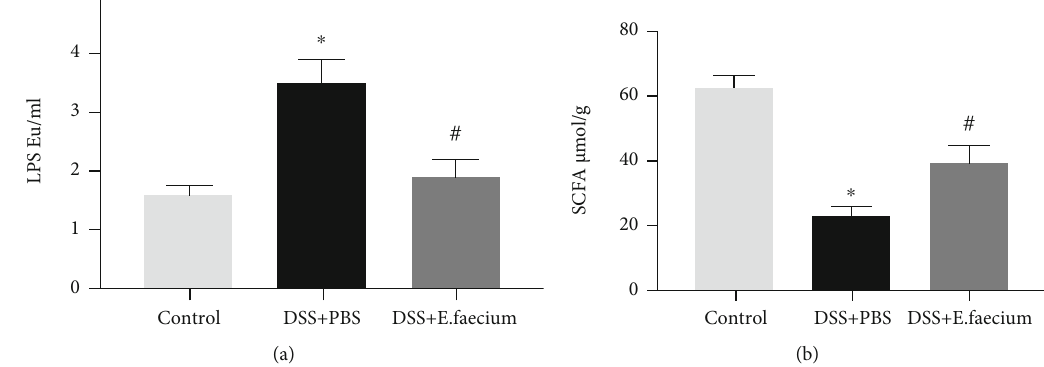
Figure 5: E. faecium treatment shifts the balance of in fl ammatory factors. The levels of (a) LPS and (b) SCFAs. ∗ P < 0 : 05 vs. control group; # P < 0 : 0 5 vs. DSS +PBS